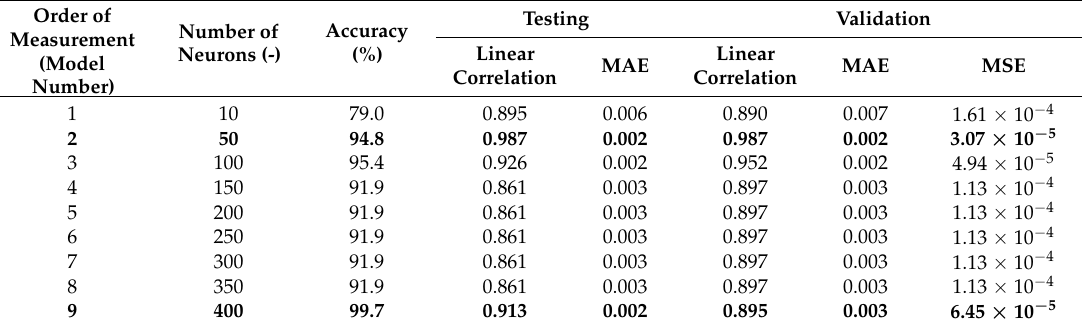
Table 7. The trained models—Training period: 15 th of November